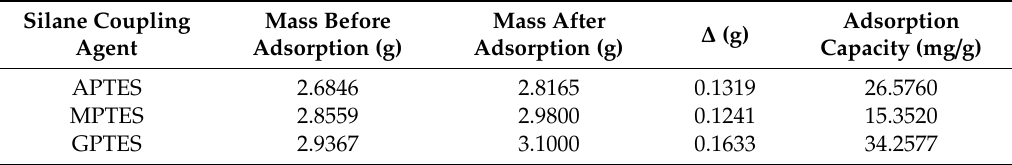
Table 2. Weight gain and adsorption capacity of SiO 2 nanospheres leather without a cross-linking agent. Silane